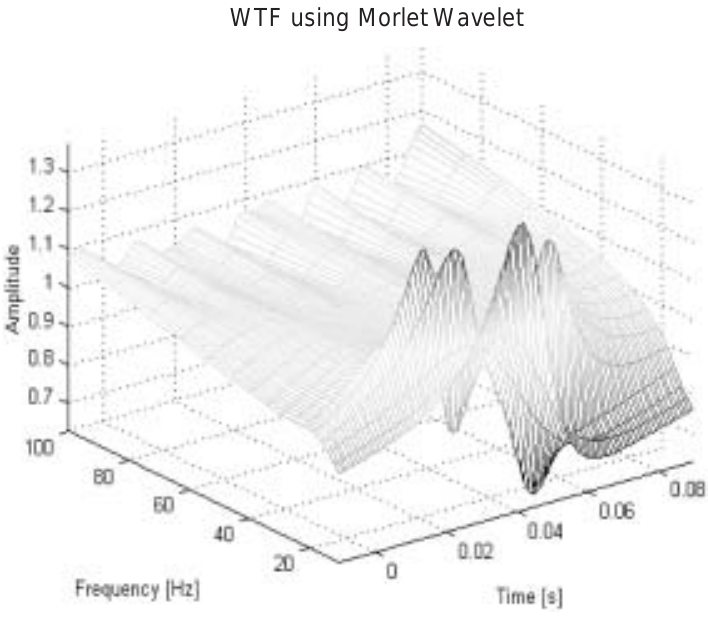
Fig. 13. WTF no clipping of the sinusoidal response of the healthy beam using sensors S1 and